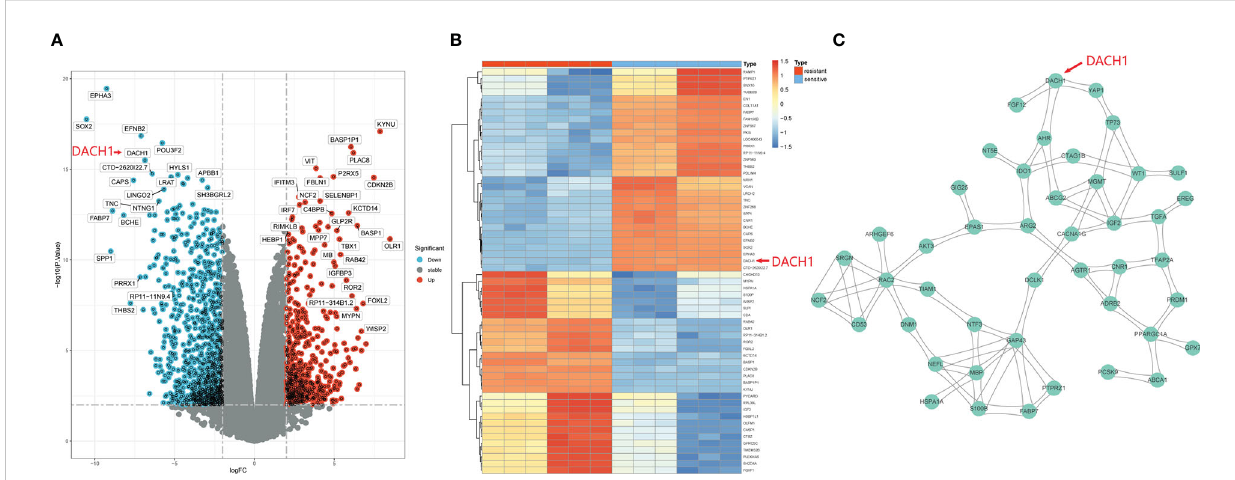
FIGURE 1 Identi fi cation of hub DEGs. (A) DEGs are shown by the volcano plot. Red dots represent genes that are upregulated in the resistance group (logFC > 2 and P.value < 0.01), and green dots represent genes that are downregulated (logFC < 2 and P.value < 0.01). (B) The heatmap shows the top 30 up- regulated and top 30 down-regulated genes in the drug resistance group. Red means genes up-regulated and blue means genes down-regulated. (C) 45 hub DEGs PPI